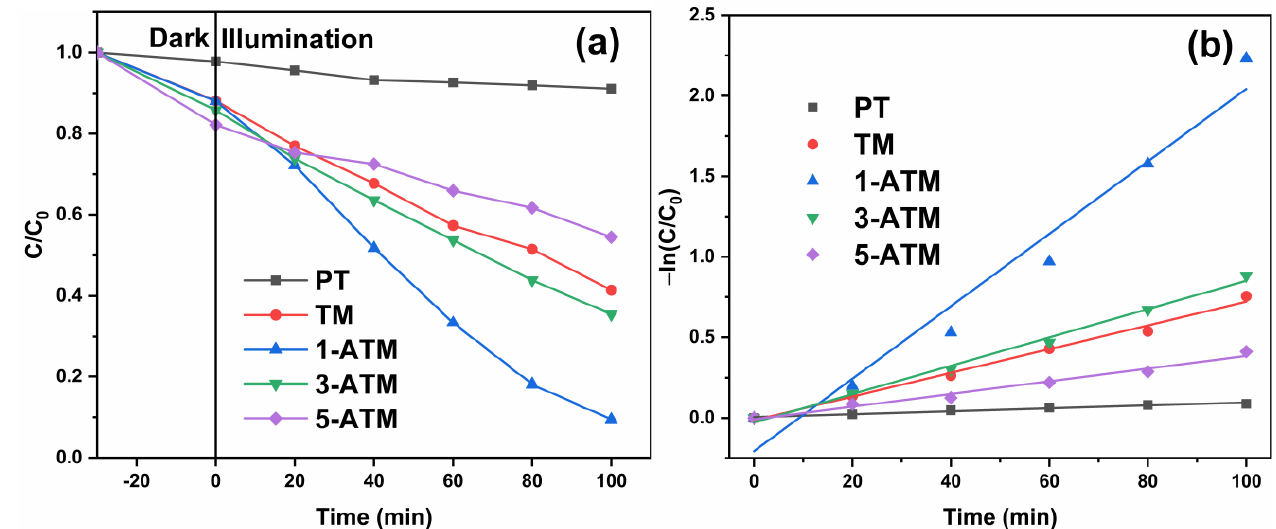
Figure 9. Degradation degree curves ( a ) and kinetics curves ( b ) of PT, TM and ATM.